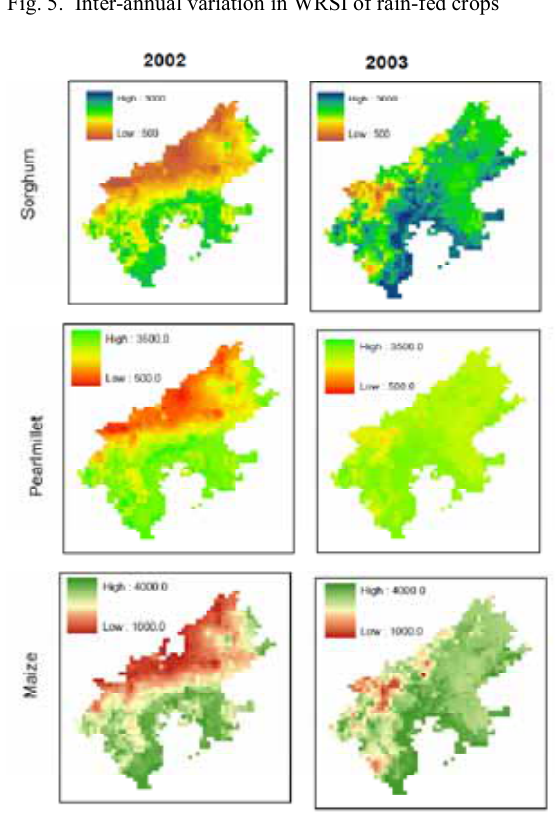
Fig. 6 Spatial pattern of water-limited yield of rain-fed crops in drought (2002) and Normal (2003)